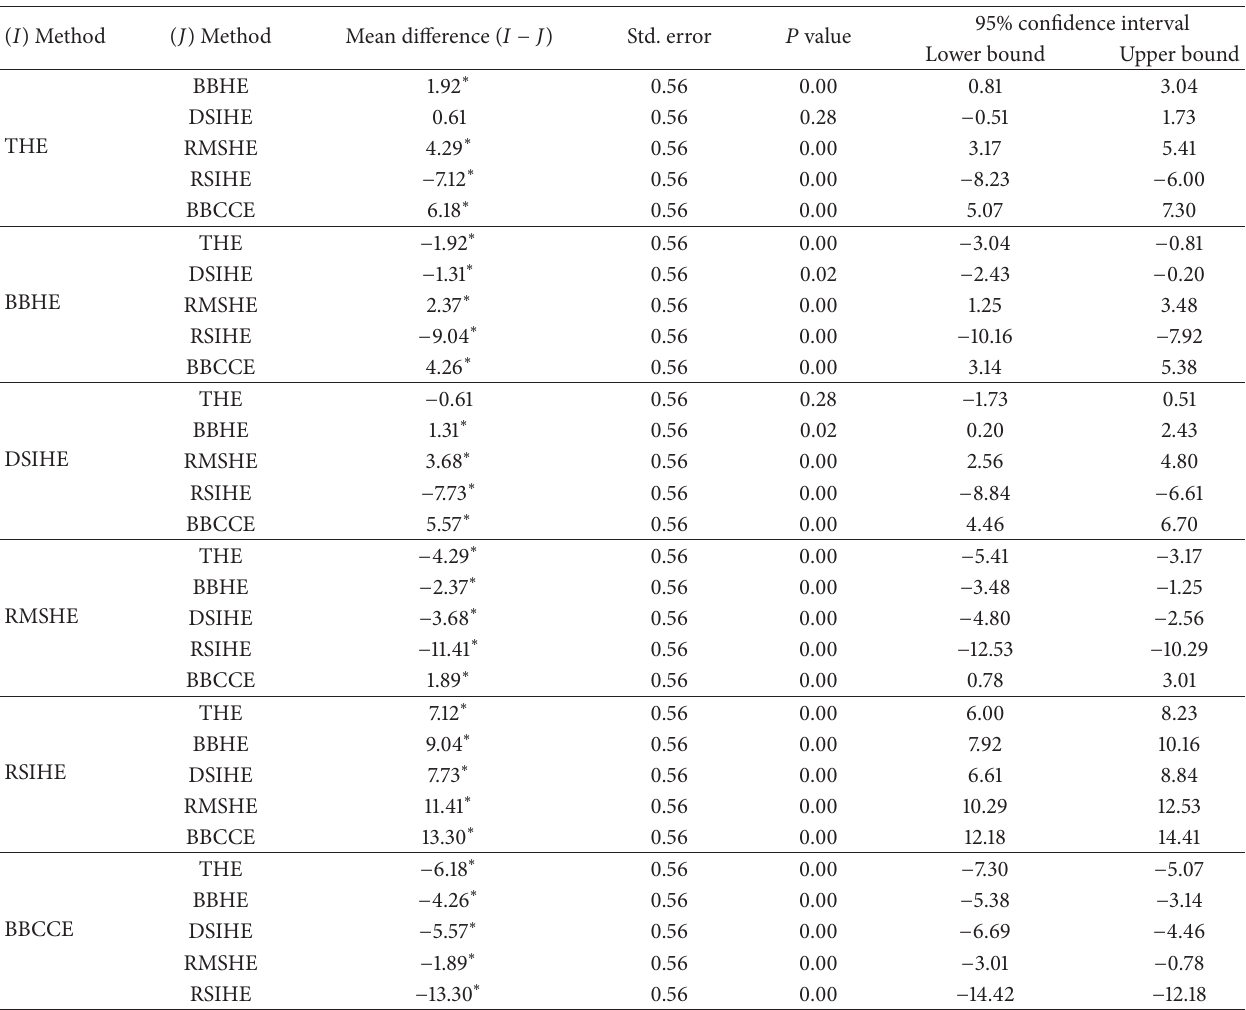
Table 3: Categorization of different methods using Fisher’s Least Significance Difference (LSD) for